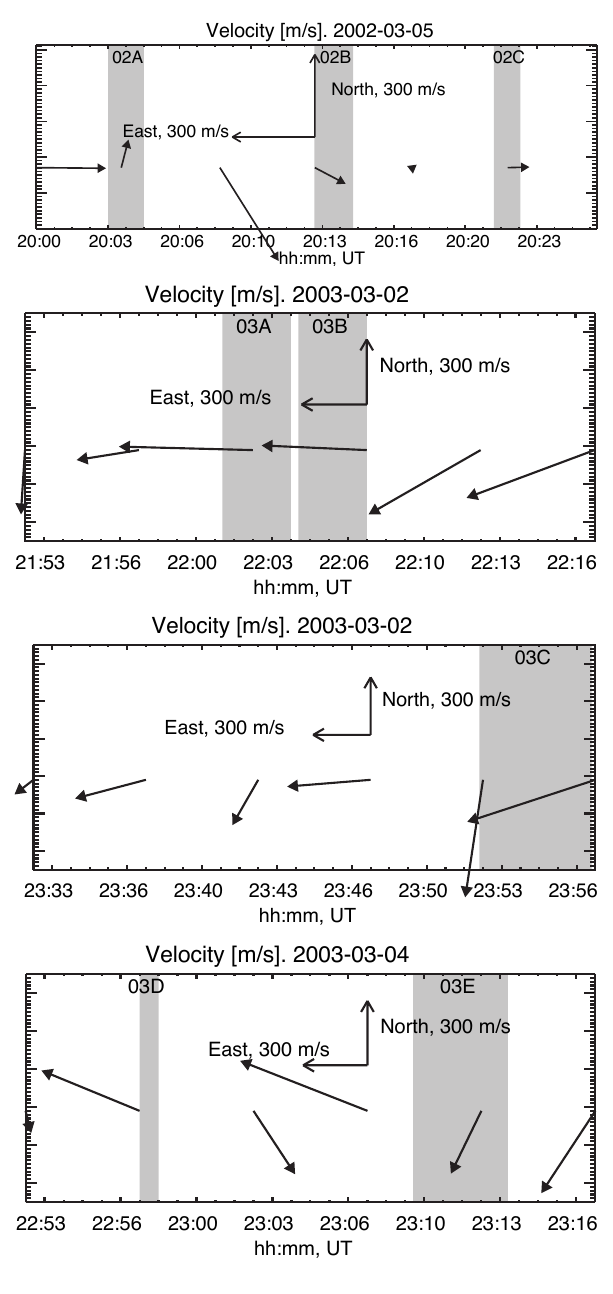
Fig. 2. Summary of the plasma drift measurements by EISCAT. The black aurora observations are indicated by the gray areas and are labeled according to Table 1.